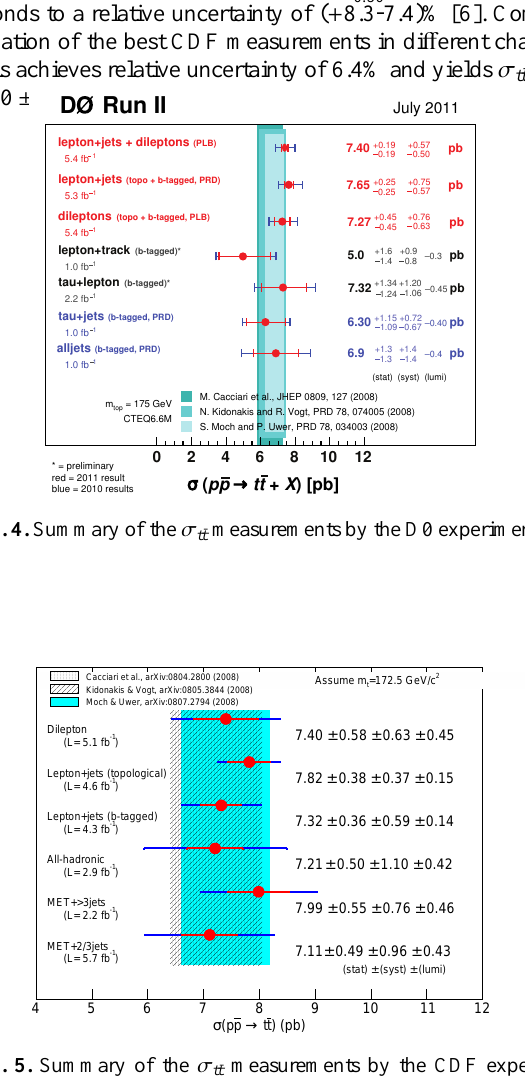
Fig. 5. Summary of the σ t ¯ t measurements by the CDF experi-